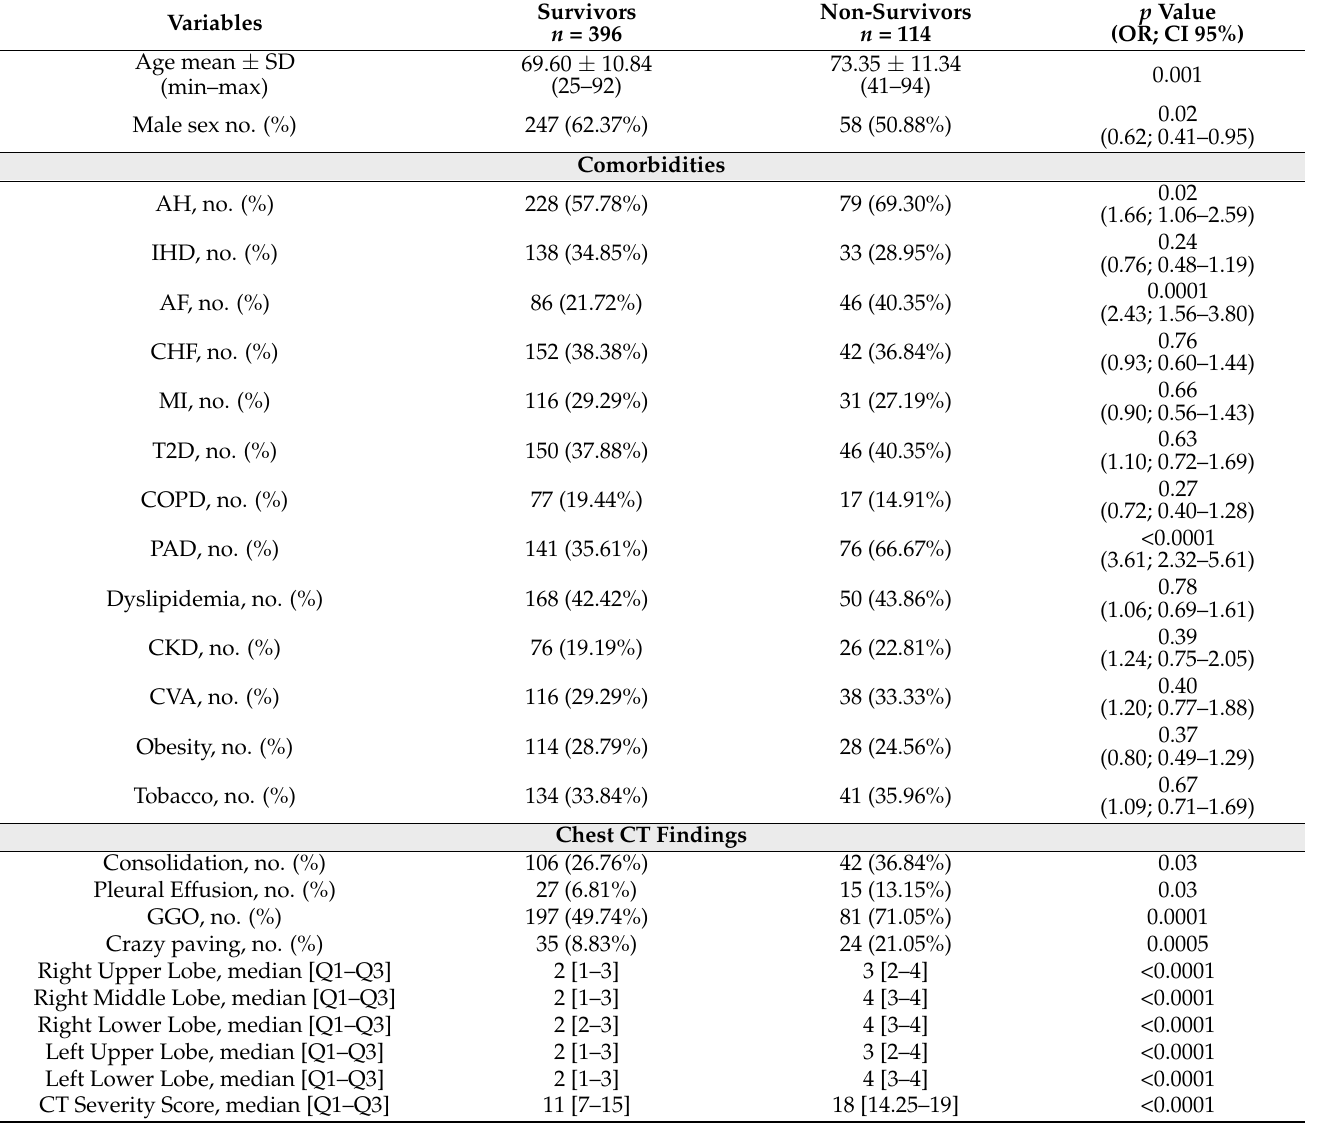
Table 2. Demographic data, comorbidities, risk factors, laboratory findings, and outcomes for all patients according to the mortality